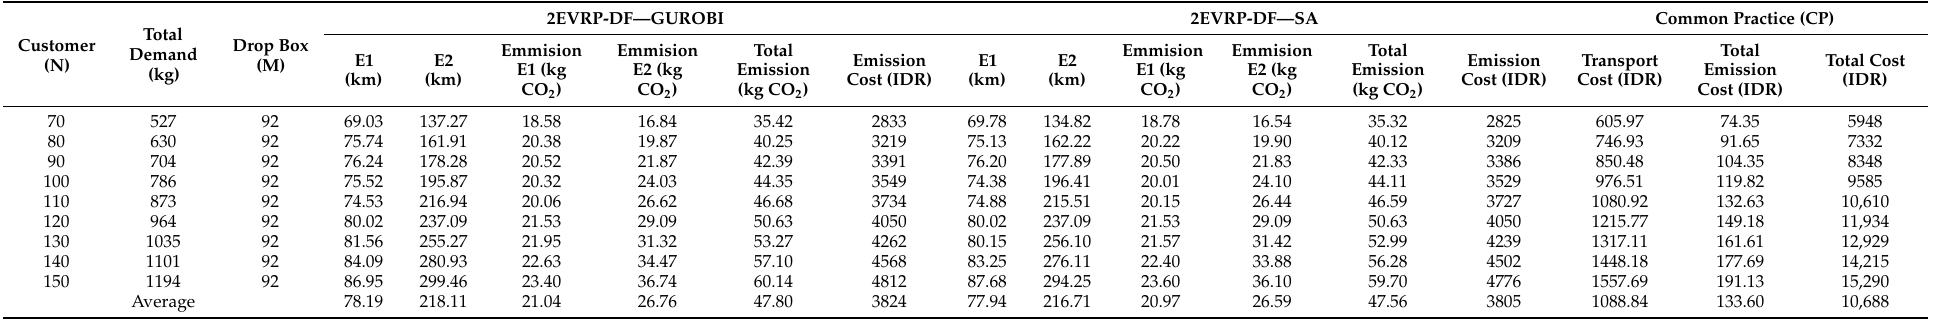
Table 6. Emission cost comparison between 2EVRP-DF and common